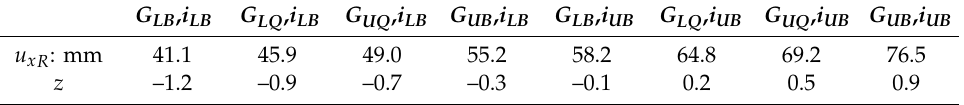
Table 5. Lateral deflections from FE analysis: maximum values at reflector point.